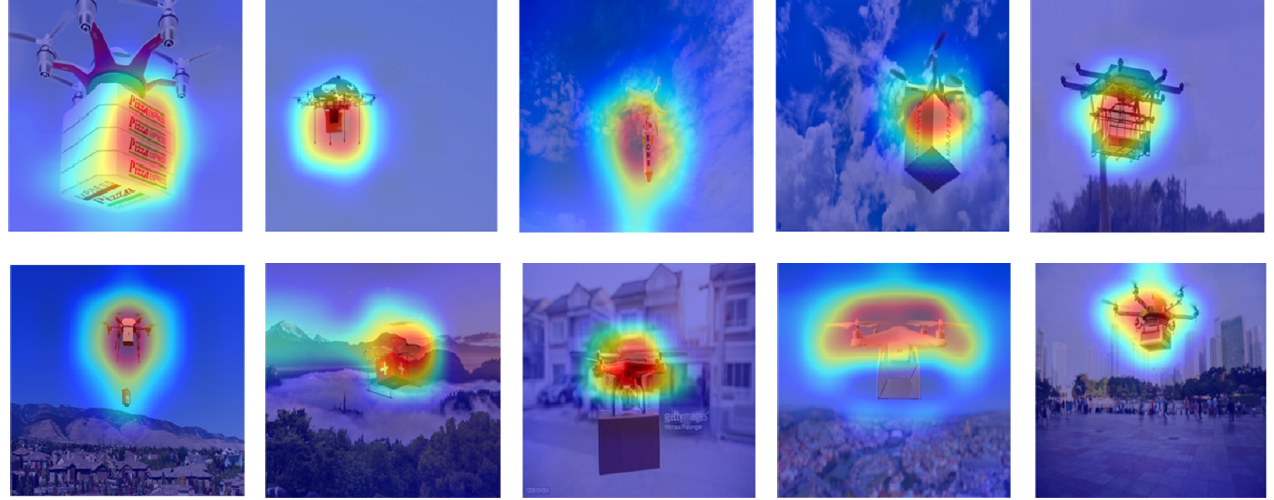
Figure 7. Hot map visualization of malicious drone images with 10% to 90% background using Grad CAM.